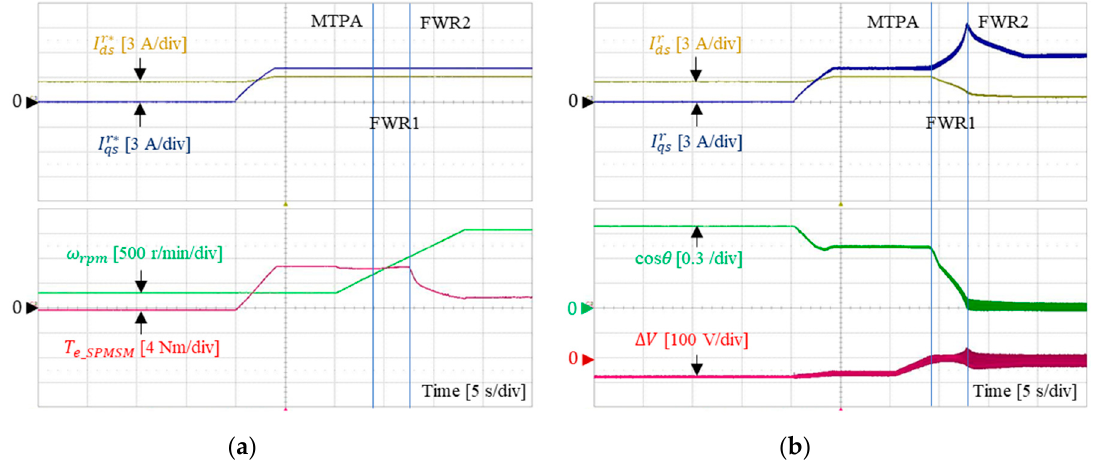
Figure 13. Experimental results with the dynamic inductance of the self-axis flux saturation model: ( a ) MTPA current reference and experimental conditions and ( b ) operation of the proposed algorithm.